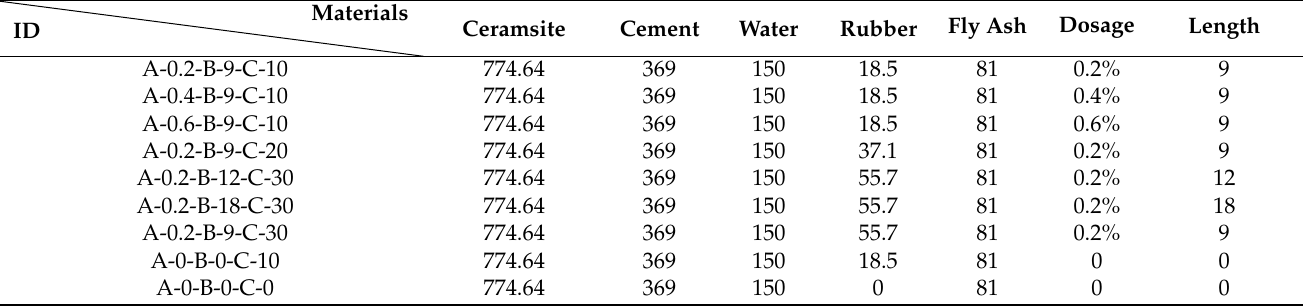
Table 2. Mix proportion (kg/m 3